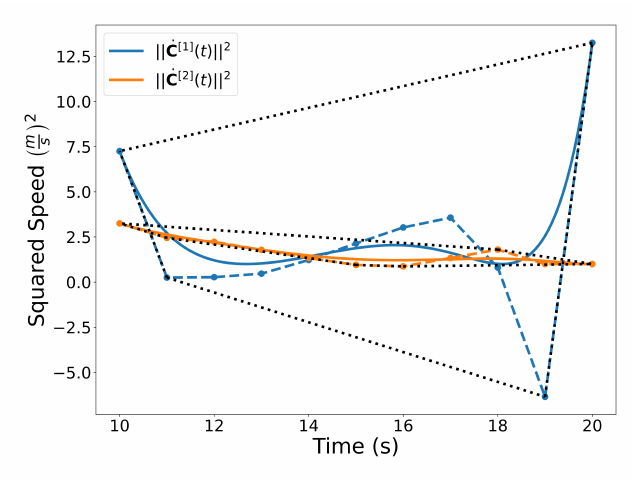
Figure 6. Squared speed of the trajectories C [ 1 ] ( t ) and C [ 2 ] ( t ) . A convex hull is drawn around the Bernstein coefficients. Note that even though the coefficients may be negative, the actual curve is not.